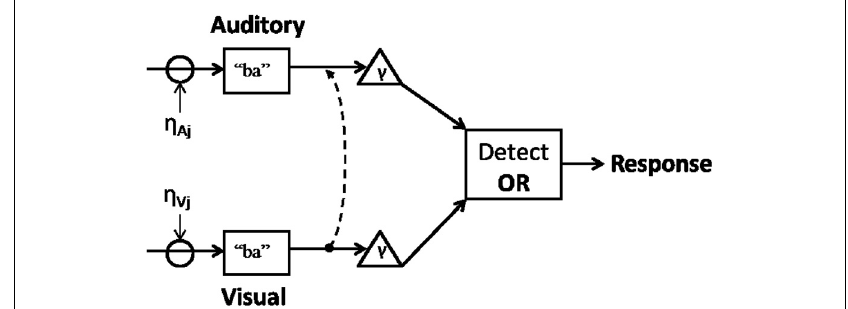
FIGURE 1 | Inputs interact with noise while evidence for a category (e.g., “ba”) accumulates toward threshold ( γ ). Once enough information in either modality reaches threshold, a decision is made (e.g., “ba” vs. “da”). Visual information interacts with auditory cortical regions (dotted line) leading to updated priors. This model does not rule out the possibility that auditory cues can reciprocally influence viseme